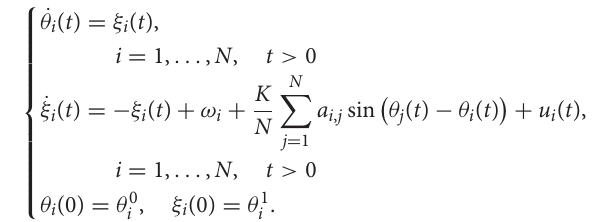
u for the Kuramoto model (22) with N b